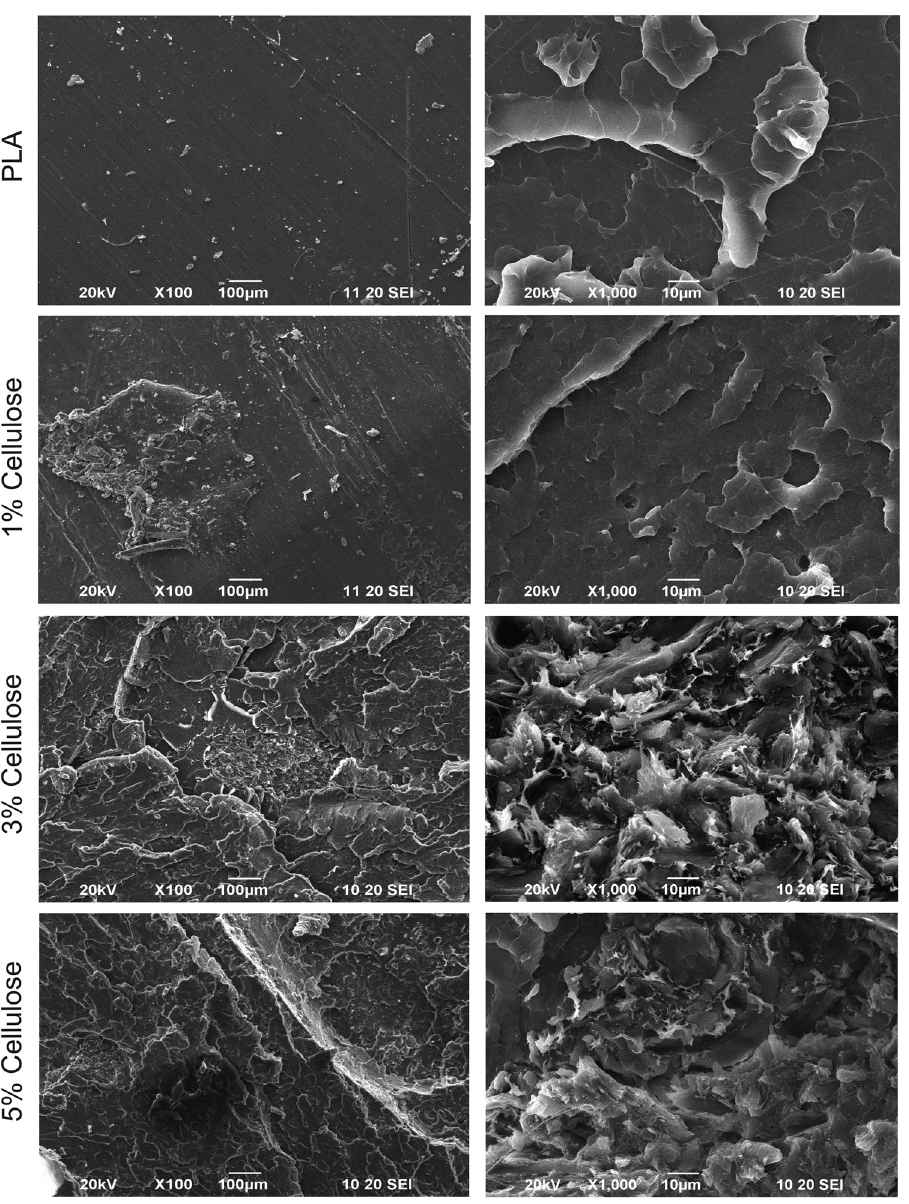
Figure 7: Scanning electron microscopy of neat PLA, 1% cellulose, 3% cellulose, and 5%